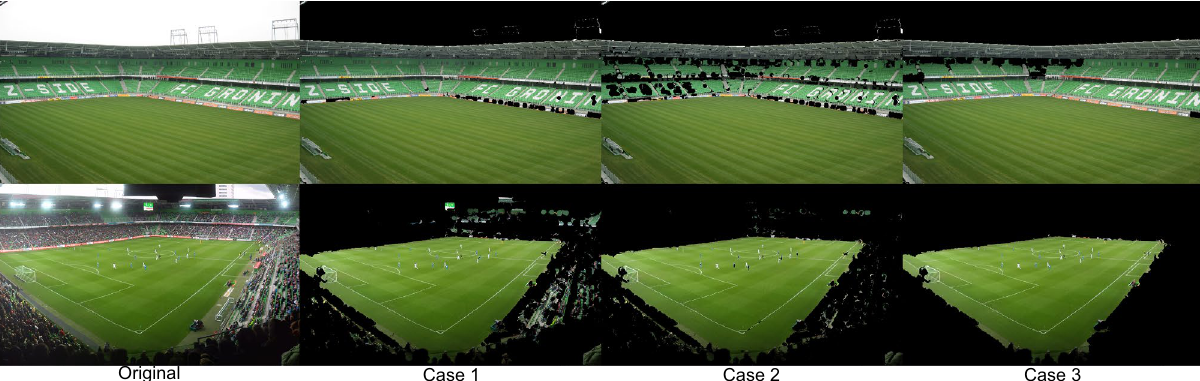
Figure 9. Results obtained in a stadium with green stands: without an audience (top row of images) and with some audience (bottom row of images). Original images from 54 and 55 .